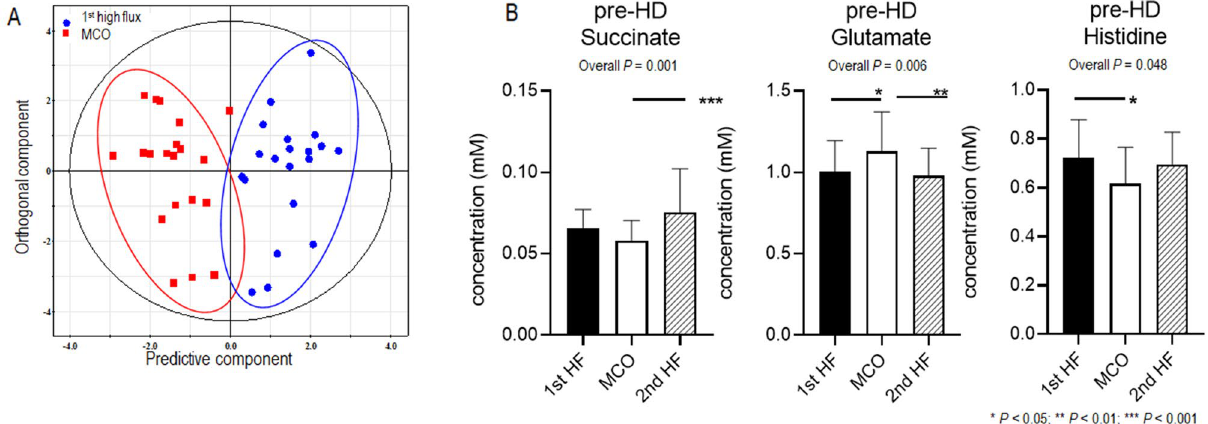
Figure 2. Metabolomics profiles according to each dialyzer period. ( A ) OPLS-DA score scatter plot derived from the 1 H NMR spectra of pre-dialysis serum obtained from subjects in the 1st HF and MCO dialyzer periods. In the OPLS-DA result, the score scatter plot (R 2 = 0.814, Q 2 = 0.368) shows a substantial separation of the 1st HF (blue circle) and MCO (red square) dialyzer periods, suggesting significant differences between these groups. Each symbol represents the metabolomic profile of an individual sample. One predictive and one orthogonal component was used for this model. The X-axis represents the covariation and the Y-axis the corresponding orthogonal score. SIMCA-P + version 12.0 software (Umetrics, Umea, Sweden) was used to perform OPLS-DA. ( B ) Pre-HD concentration of metabolites with a VIP score > 1.0 in both the 1st HF versus MCO and MCO versus 2nd HF dialyzer comparisons. The P values were calculated using the repeated measures one-way analysis of variance using GraphPad Prism version 9.0.0 for Windows (GraphPad Software, San Diego, California USA, www. graph pad. com): * < 0.05, ** < 0.01, *** < 0.001. OPLS-DA, orthogonal partial least-squares discriminant analysis; NMR, nuclear magnetic resonance; HF, high flux; MCO, medium cut-off; VIP, variable important in projection; HD,